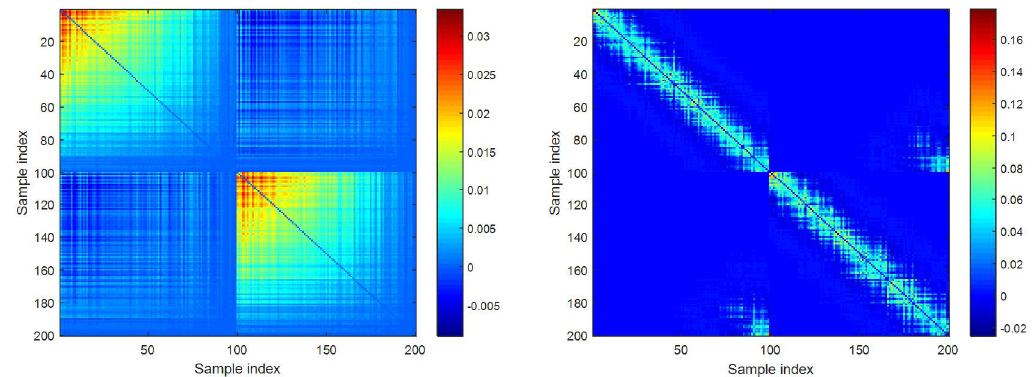
Figure 4. Illustration of coefficient matrix obtained by SR-EN ( left ) and KSR-EN ( right ). Table 1. Imputation error root mean square error (RMSE) and relative error (RELERR) obtained by different approaches. The best results are highlighted in bold.